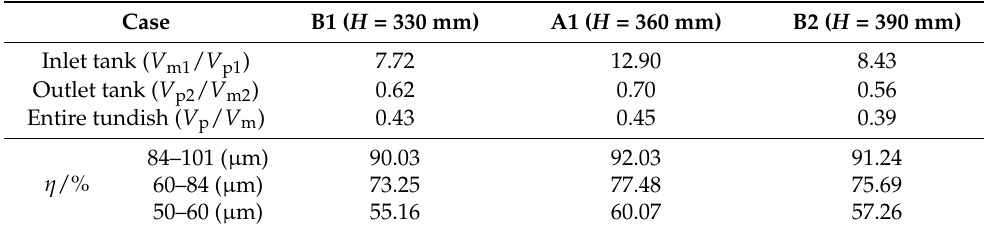
Table 8. Ratio between mixed flow and plug flow and inclusion removal rate of Cases B1, A1 and